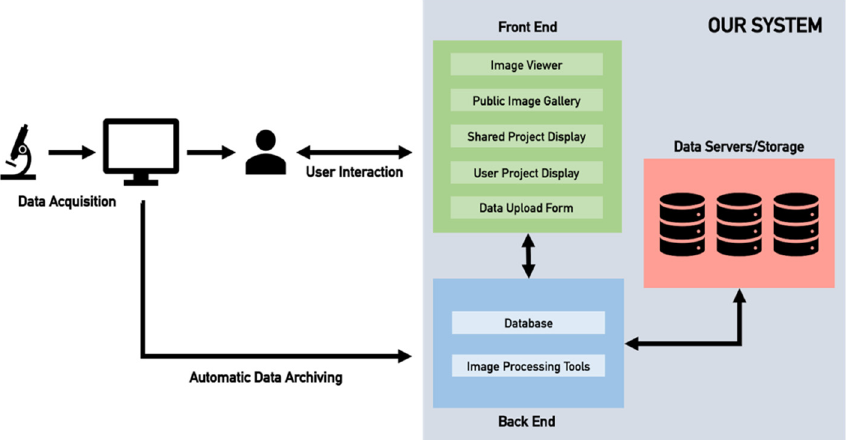
Figure 2. Current implementation of the structure and components of the web-based application designed on a data-driven bottom-up approach for efficient biomedical image data storage and management.